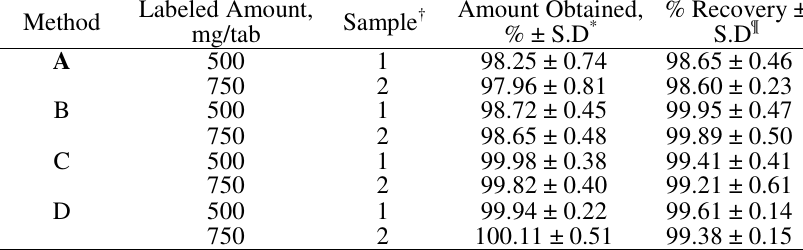
Table 2. Evaluation of sulfadoxine in pharmaceutical